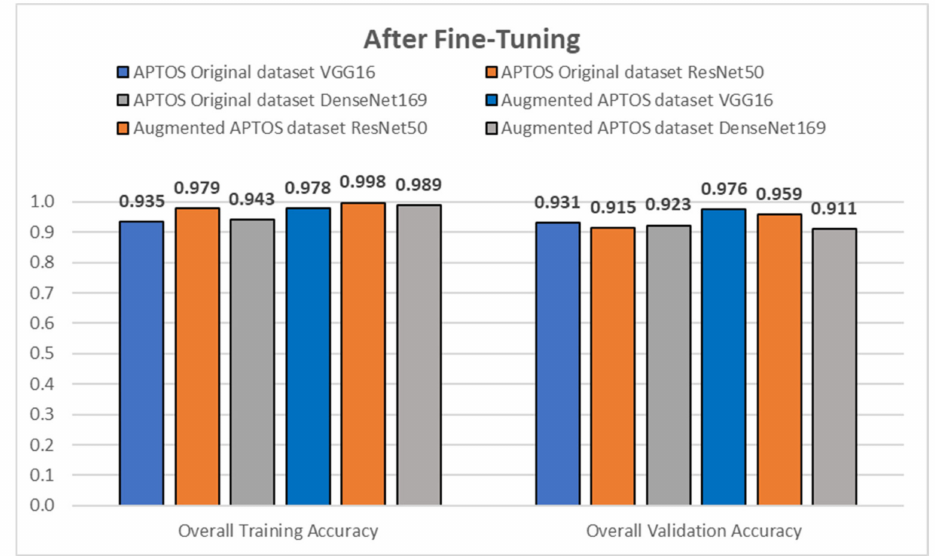
Figure 9. Overall training and validation accuracy of the CNN models after fine-tuning.